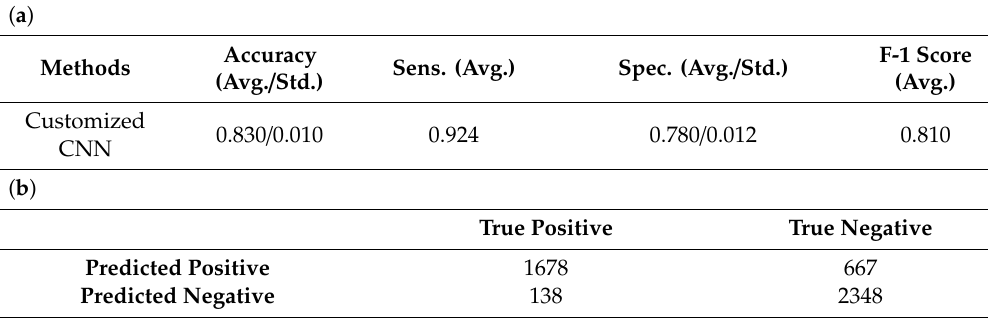
Table 5. Performance measurement ( a ) and the confusion matrix of one test fold ( b ) for customized CNN approach on test images. Positive: non-cervix image. (Sens. = Sensitivity, Spec. = Specificity, Std. = Standard deviation, Avg. =